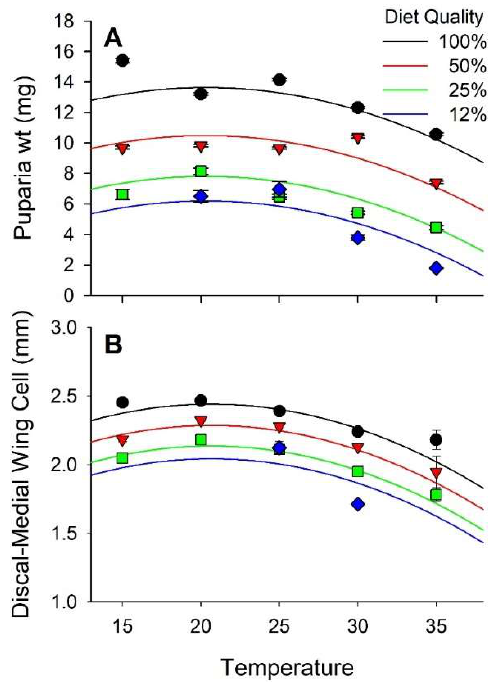
Figure 2. Effect of diet quality and temperature on size of stable flies. ( A ) is weight of the puparia; ( B ) is length of the discal medial cell of the wing.